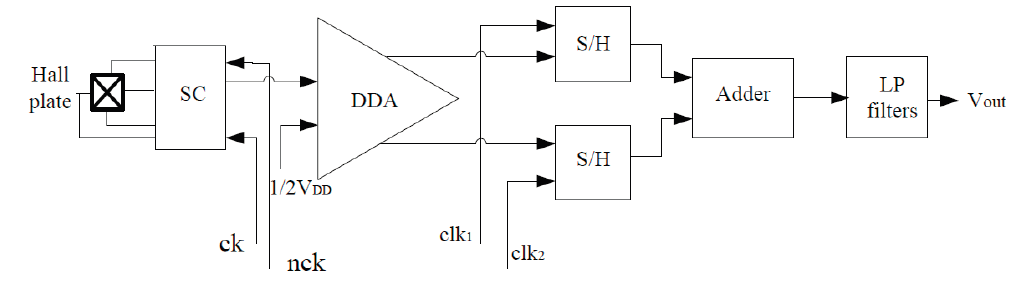
Figure 4. Block diagram of CMOS integrated linear Hall sensor